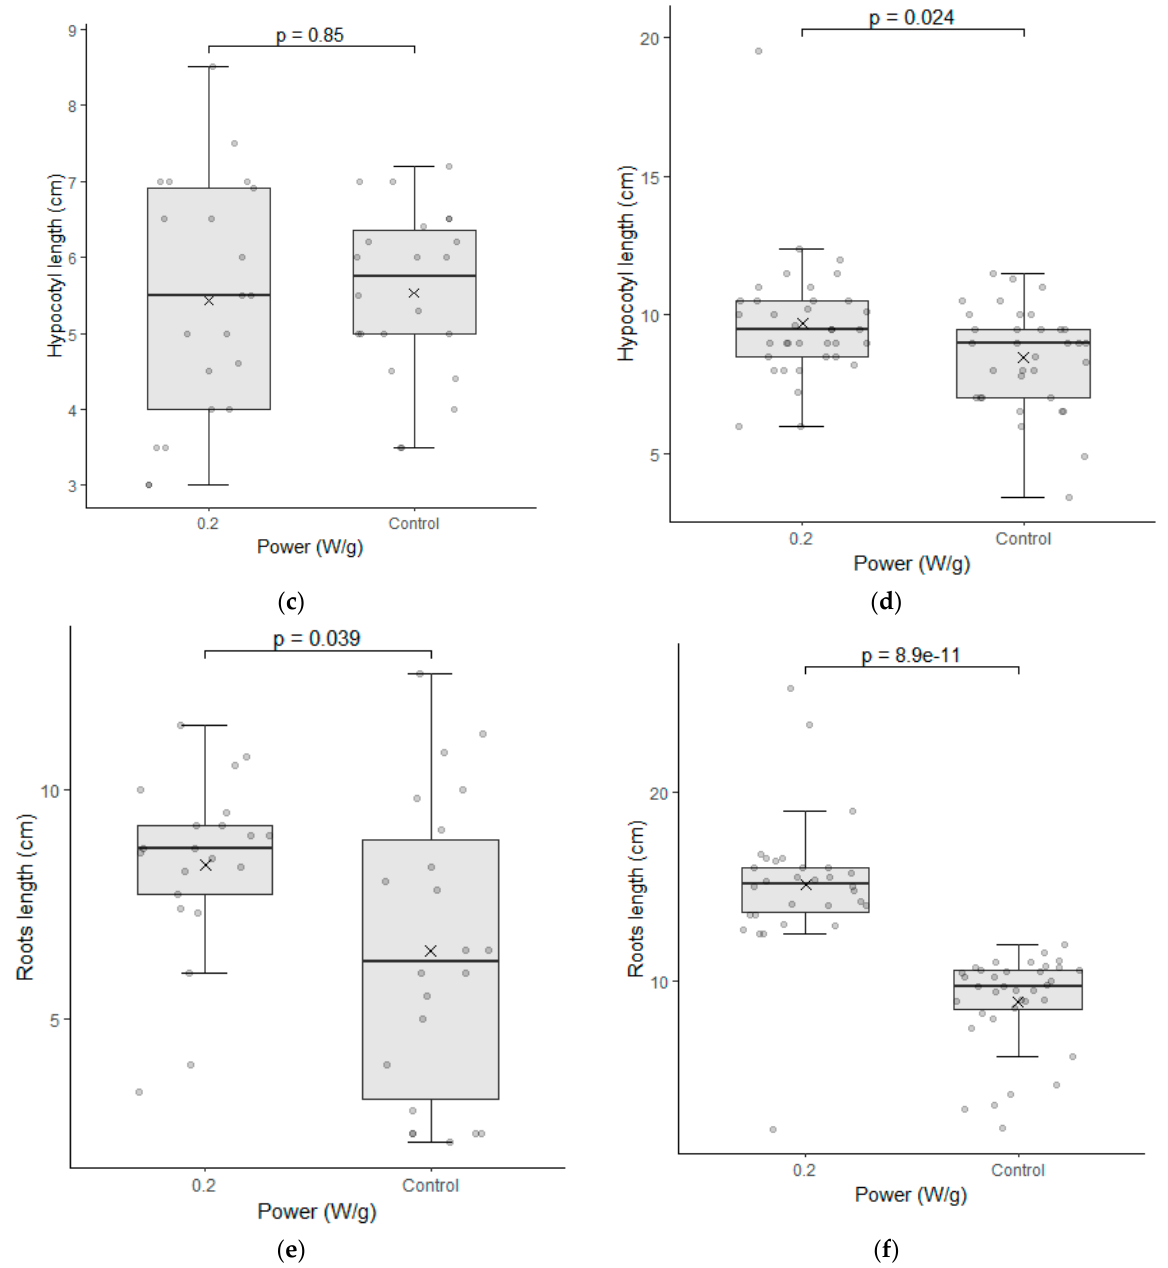
Figure 5. Seedling length test between the seeds of the control group (0 W/g) and those subjected to the magneto-priming (0.2 W/g). On the left, Figures ( a , c , e ) are related to cultivar C01; on the right, Figures ( b , d , f ) refer to cultivar C02. The differences were estimated by the Mann–Whitney U test at a significance level of 0.05. The media, data, and p value are represented in the figures for the x, dots, and letter p , respectively.